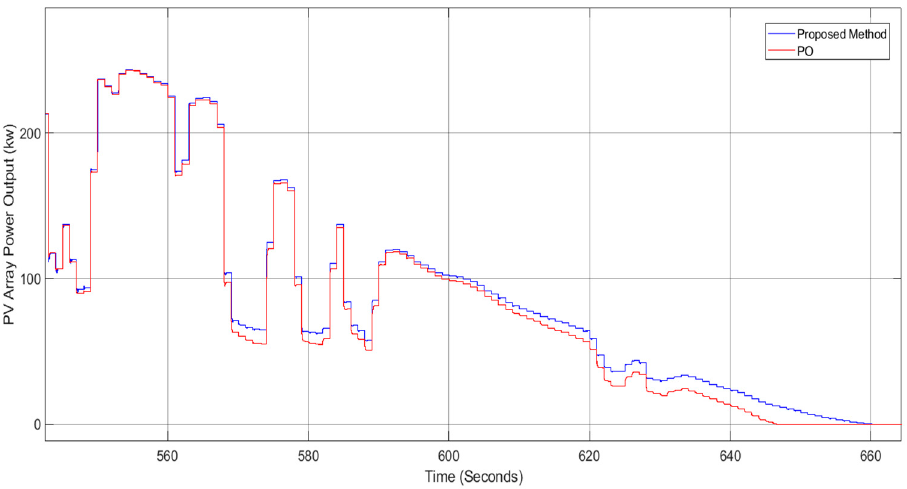
Figure 10. Sample of the output power of the proposed method and the PO method for a period (560–660) of time on a cloudy day.